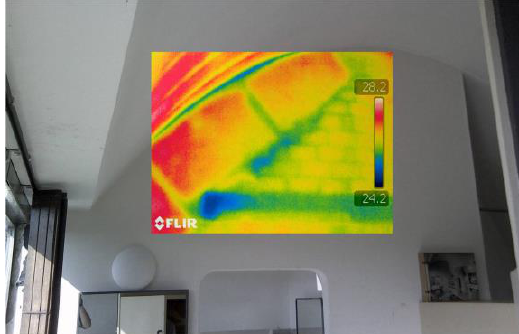
Figure 4. © A-BIME: Infrared camera picture: structure of the bedroom wall